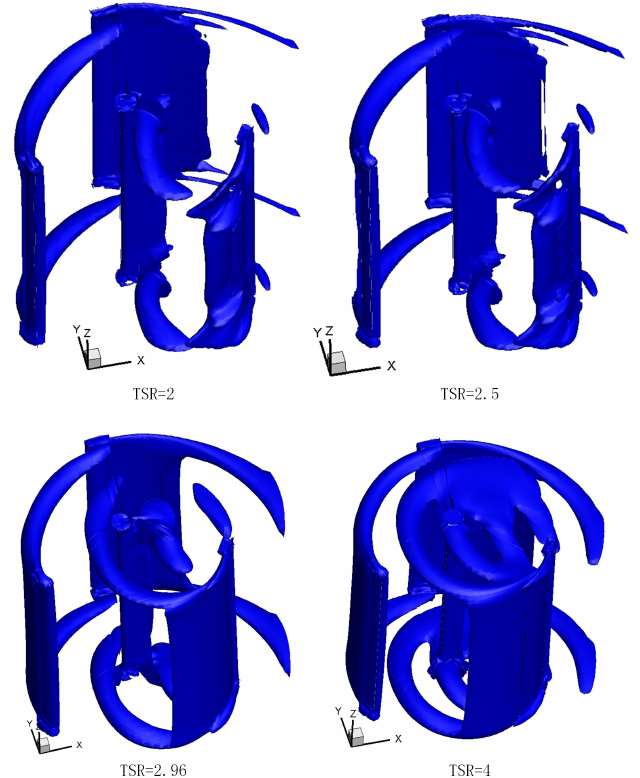
Figure 17. Vorticity diagram of three-dimensional offshore wind turbine with different TSR ( Vorticity Magnitude = 50 s − 1 ).